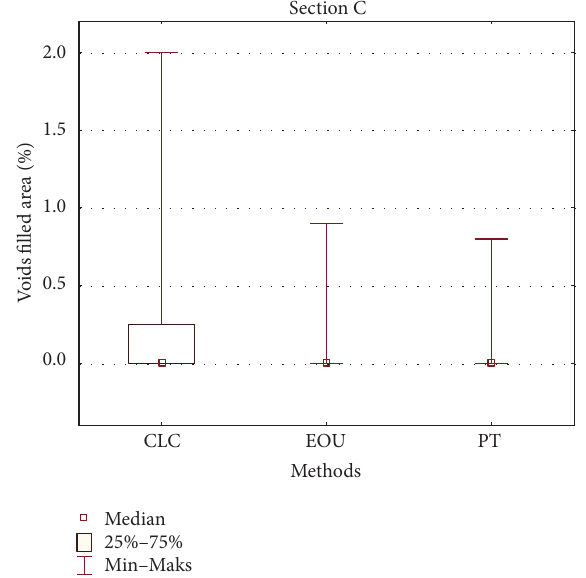
Figure 10: Box plots illustrating the median traces and minimal and maximal values of the voids in the filled area in each experimental group, section A.